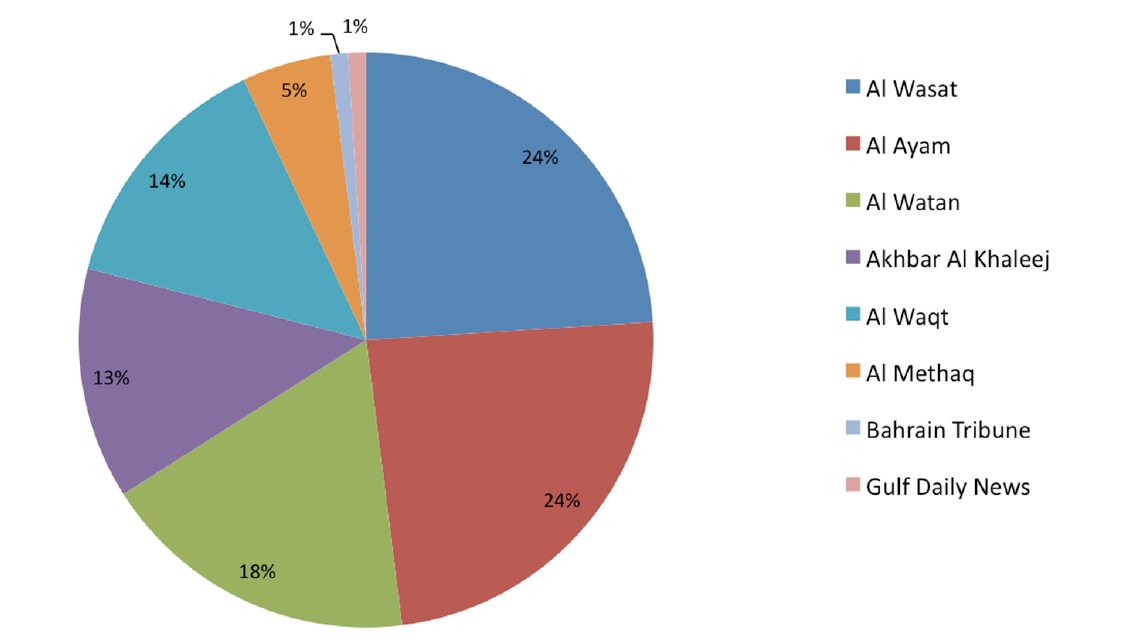
Source : Bahrain Media Supervision Report 2006 .